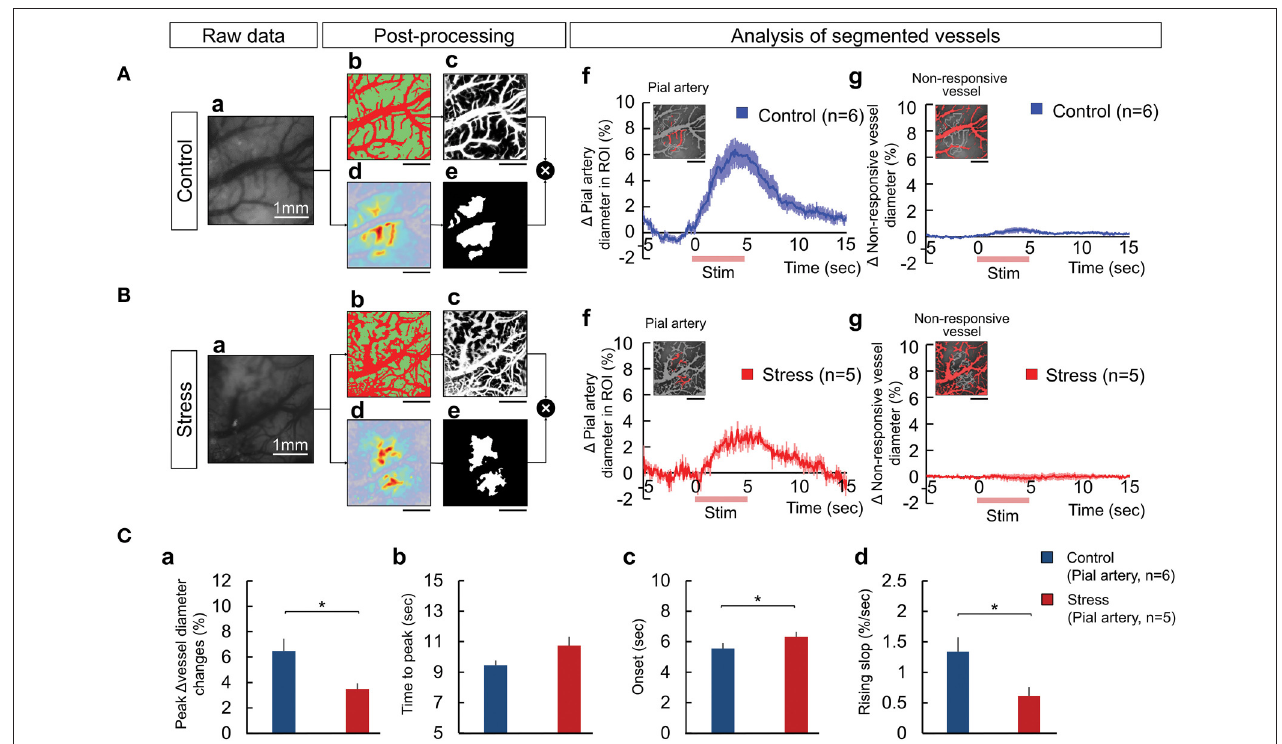
FIGURE 3 | The process of vessel segmentation used to extract the responsive pial artery to measure the hemodynamic response upon peripheral somatosensory stimulation in the control (A) and 3-week stress (B) groups. The responses of the vessels were displayed as the changes in the number of pixels over the threshold, a standard for distinguishing the vessels from the tissues. The vessel segmentation was performed by combining a Weka segmentation-training method (image J) and standard deviation mapping: (Aa,Ba) raw image, (Ab,Bb) classified images of the vessel and tissue using Weka segmentation method in the raw image (the red region represents the vessel and the green region represents the tissue), (Ac,Bc) vessel probability map, (Ad,Bd) a color-coded standard deviation map (SD map), (Ae,Be) the mask image used to define the “responsive area” based on the SD map, (Af,Bf) the responsive pial artery defined by the mask image overlapping the vessel probability map and the dynamics of the responsive pial arterial diameter, and (Ag,Bg) the non-responding vessels upon electrical stimulation and dynamic changes of the vessel diameters. The red lines on the x-axis in (Af,g,Bf,g) indicate the hindpaw stimulation period. All scale bars under the representative segmentation images indicate 1mm. (C) Comparisons of the dynamics between the pial artery of the control and stress groups in the maximum vessel dilation change (Ca) , the time to maximum peak (Cb) , the onset time (Cc) , and the rising slope (Cd) [Control ( n ) = 6 and Stress ( n ) = 5, Independent t -test, * p < 0.05